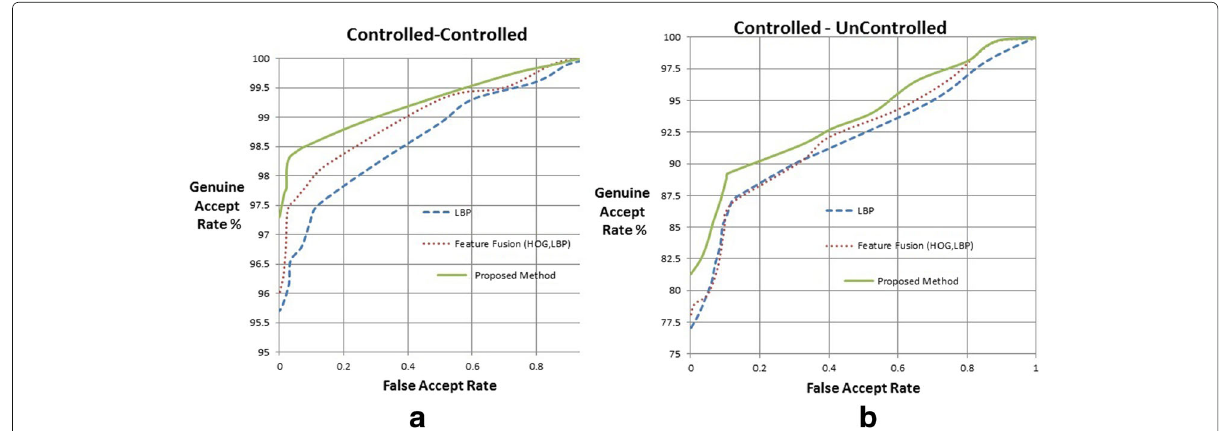
Fig. 6 ROC curves for a controlled-controlled illumination/ b controlled-uncontrolled